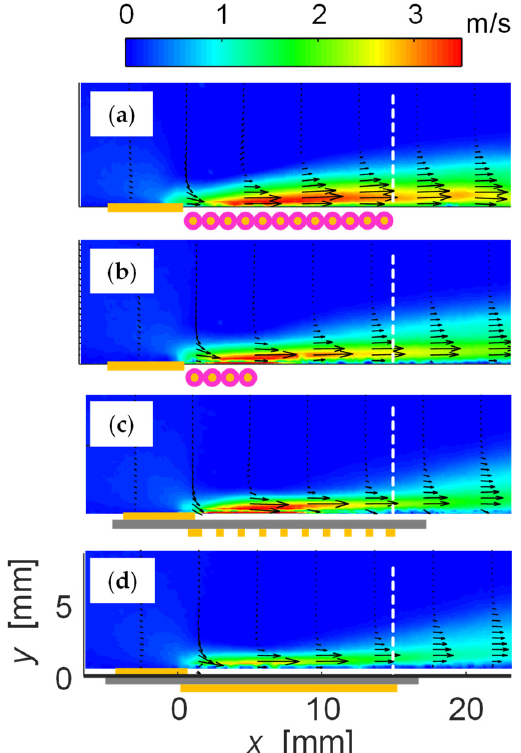
Figure 6. Velocity distributions in the x – y cross-section analyzed by PIV for 80 < P PA < 90 W/m. ( a ) String-array-type PA with 12 wires for P PA = 79.5 ± 5.1 W/m at V p-p = 18 kV; ( b ) four wires for 81.5 ± 4.3 W/m at 20 kV; ( c ) discretized sheet-type PA for 88.0 ± 2.4 W/m at 13 kV; ( d ) reference sheet-type PA for 87.2 ± 2.0 W/m at 11 kV.